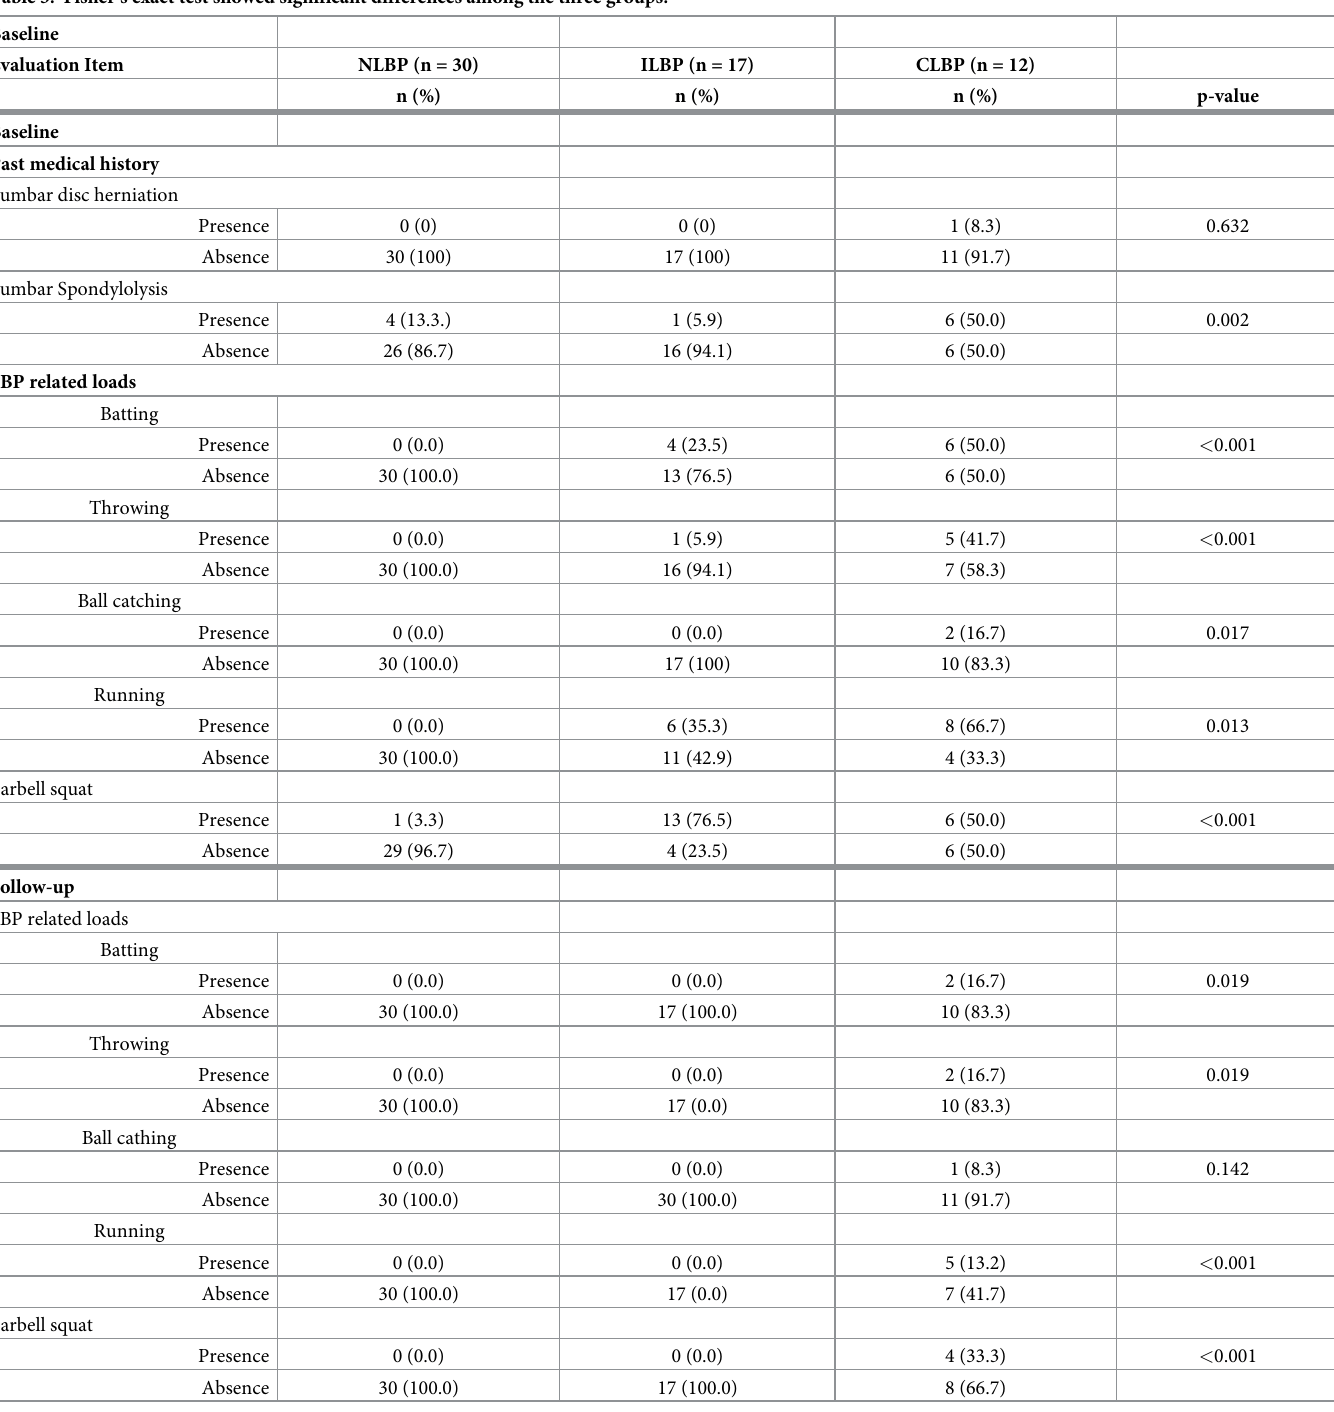
Table 3. Fisher’s exact test showed significant differences among the three